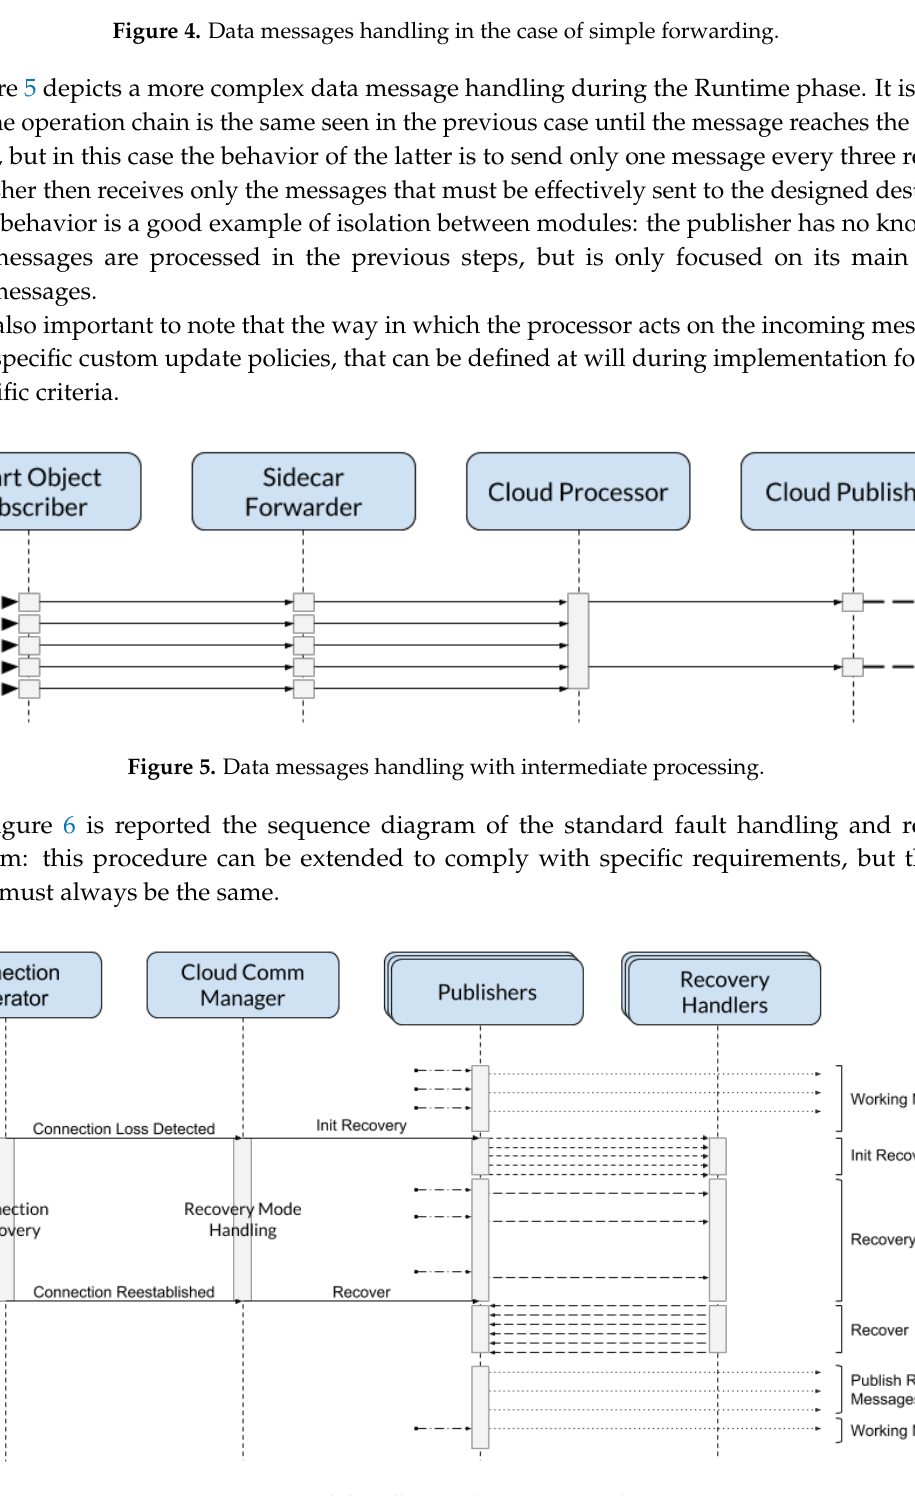
Figure 6. Fault handling and recovery